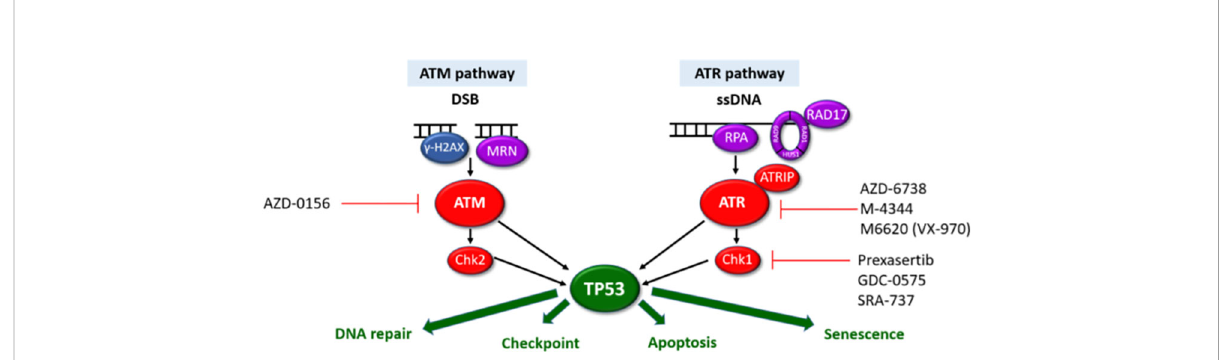
FIGURE 1 ATM and ATR DDR pathways. The ATM and ATR pathways respond to different types of DNA damage with separate sensors (purple), mediators (blue) and transducers (red). Synthetic lethality can be exploited for cells with aberrant DDR pathways. Cells harbouring LOF mutations in one pathway have increased reliance on the other pathway for DNA damage repair. Inhibition of the intact pathway prevents p53-mediated DNA repair, cell cycle arrest and apoptosis. This results in accumulation of unrepaired DNA damage, mitotic catastrophe triggering p53-independent cell death. Pharmacological agents targeting components of the ATM/ATR pathways currently in clinical development are